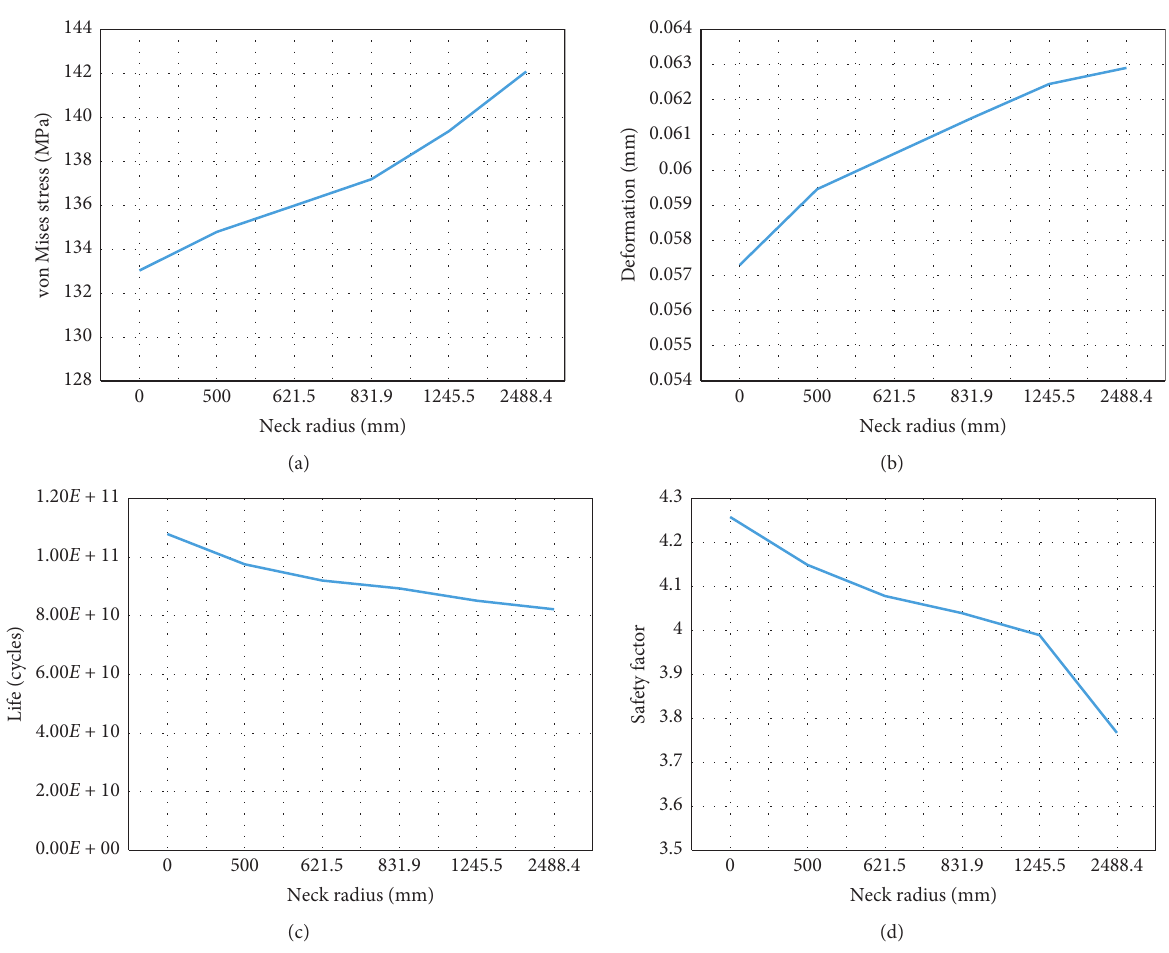
Figure 20: A graph of results for designs with different neck radii and with modeled crack: (a) equivalent stress verses neck radius, (b) deformation versus neck radius, (c) fatigue life versus neck radius, and (d) safety factor versus neck